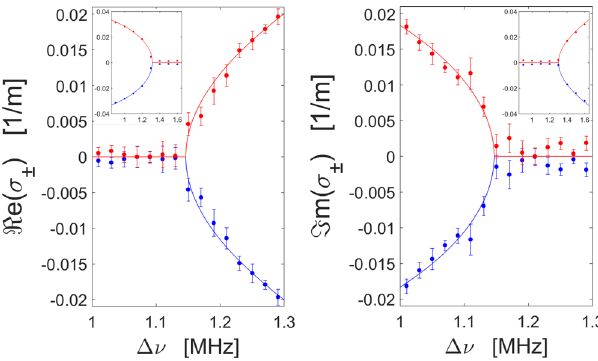
Fig. 2 EP singularity and anti-PT-symmetry breaking. Measured (dots) and theoretical (solid lines) ℜ e (left) and ℑ m (right) parts of the eigenvalues of the system. The means of the two eigenvalues have been subtracted. Each point is an average of four measurements and the error bars denote one standard deviation. The phase transition and square- root- like dispersion around the EP are evident. Insets show results over a larger, more coarse scanning range Δ v , to highlight the transition towards linear dependence away from the